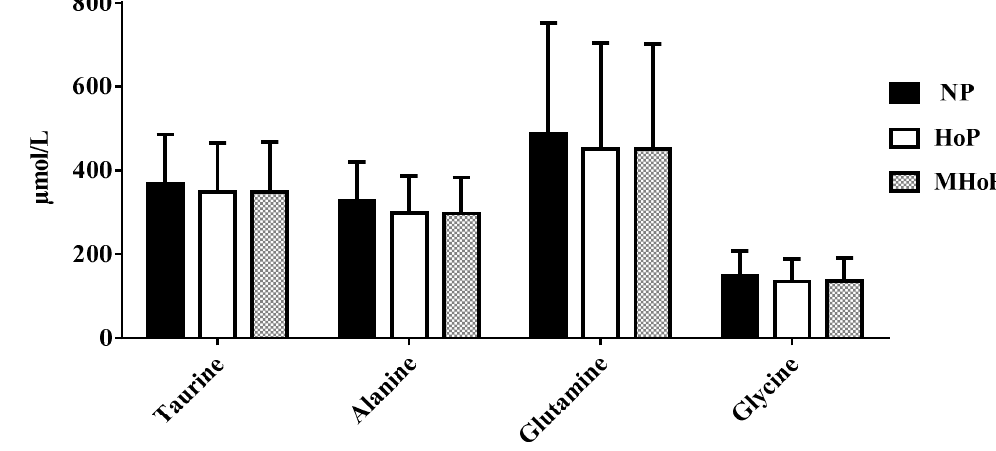
Figure 4. Amino acids concentration in not pasteurized, pasteurized by Holder method, and pasteurized by modified Holder method aliquots. NP—not pasteurized; HoP—Holder pasteurization; MHoP—modified Holder pasteurization.